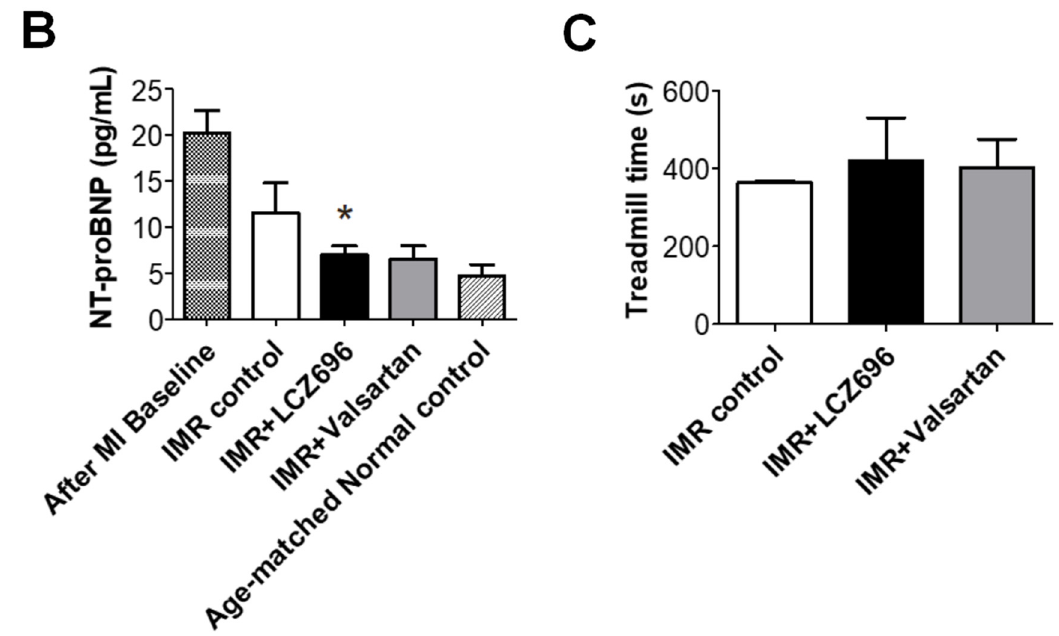
Figure 6. ( A ) Representative pressure-volume loops from the three groups. The LCZ696 and valsartan treatment groups had smaller left ventricular volume and higher end-systolic pressure-volume relation (red line) compared with the control group. ( B ) The NT-proBNP level after 6 weeks of LCZ696 treatment was significantly decreased compared with the baseline level immediately after MI and it was similar to that of the age-matched normal control group without MI. ( C ) Comparisons of treadmill exercise duration among the three groups at 6 weeks after MI. IMR indicates ischemic mitral regurgitation; NT-proBNP, N-terminal pro B -type natriuretic peptide; MI, myocardial infarction. * p < 0.05 for differences from the control group.